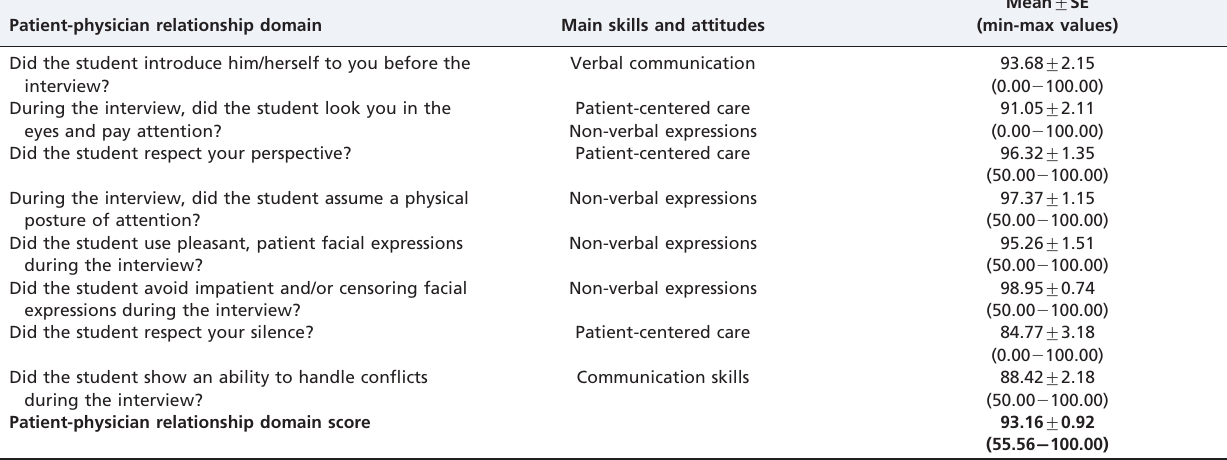
Table 3 - Patient safety checklist: the patient-physician relationship domain with the related competency and student